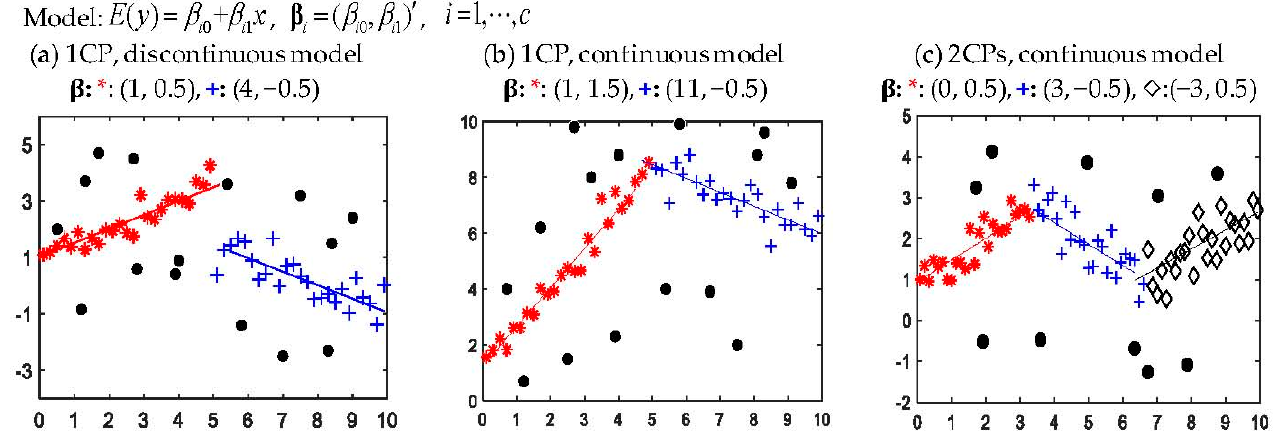
Figure 3. Plots of models used for comparing the proposed approaches with existing methods. Table 2. Comparisons of 7 methods with models a–c under 4 different situations, respectively.